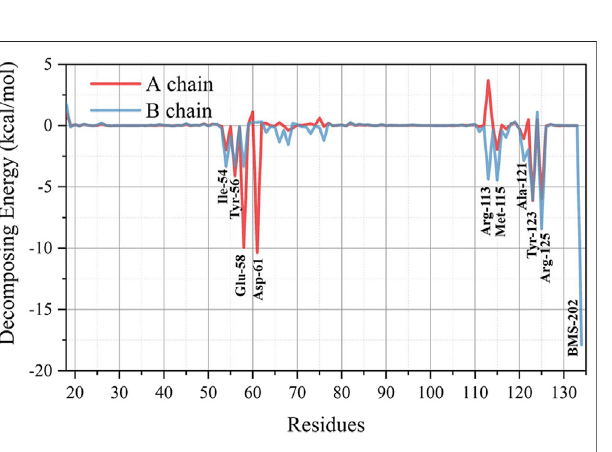
Frontiers in Chemistry |